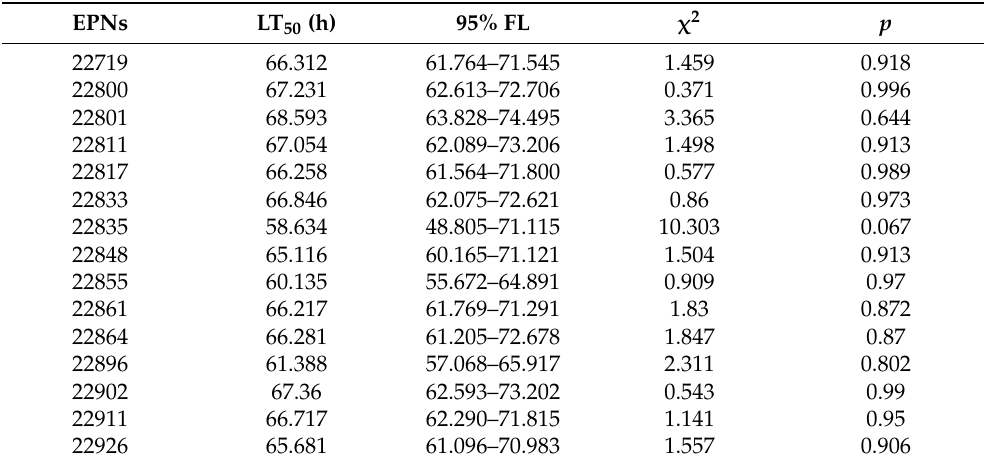
Table 1. Comparison of median lethal times (LT 50s ) in the third-instar larvae of Spodoptera frugiperda by entomopathogenic nematodes (EPNs).